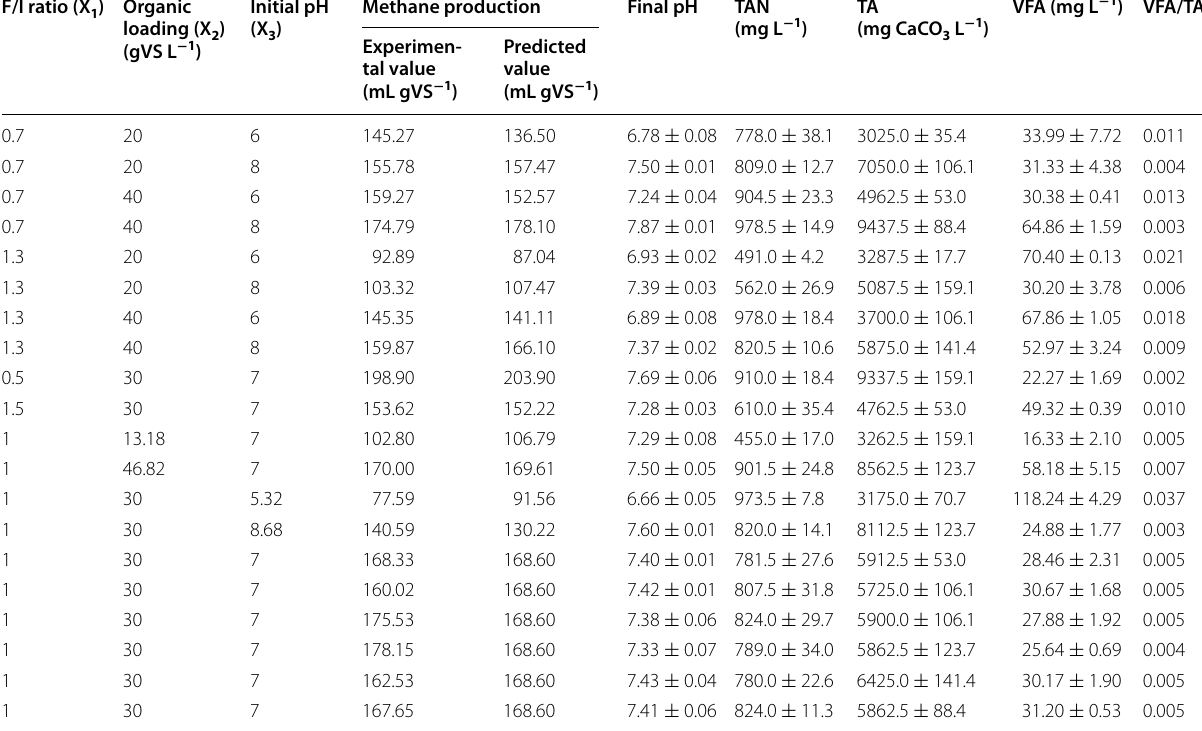
TAN total ammonia–nitrogen; TA total alkalinity; VFA volatile fatty acids